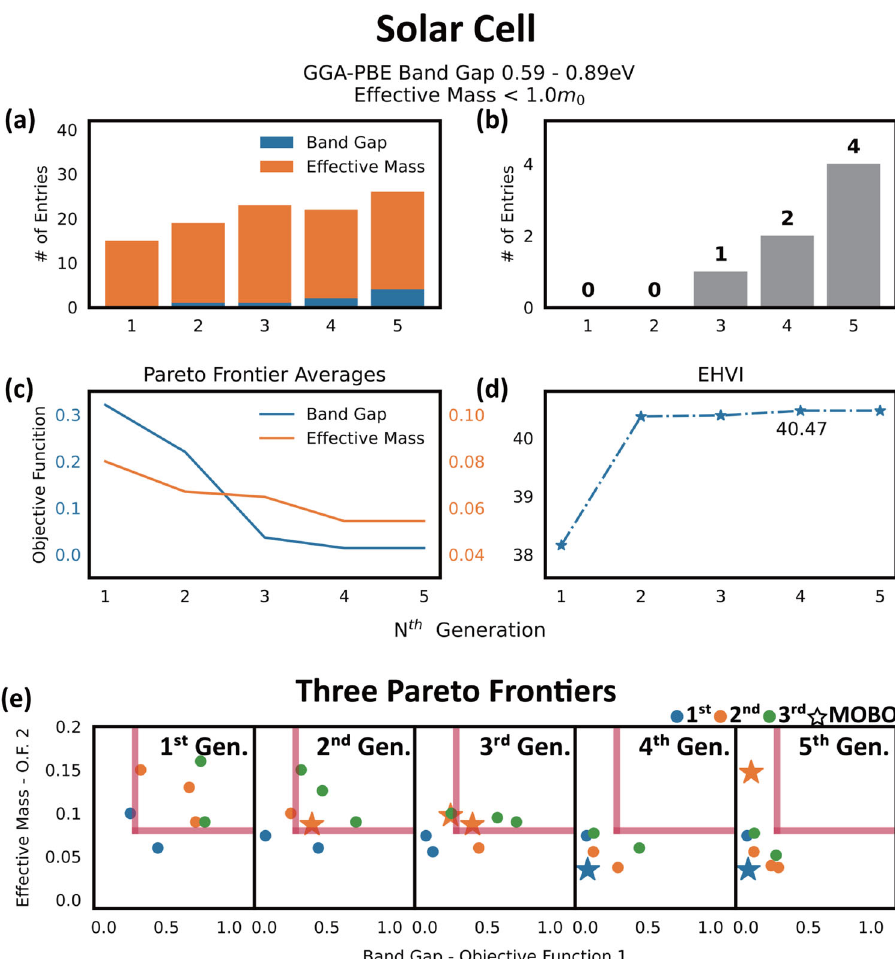
Fig. 4 NSGA-II/MOBO screening results targeting HOIPs for solar cell applications. a The numbers of HOIP candidates exhibiting 0.61 < GGA_Eg < 0.87 eV and m e/h < m o . b The number of promising entries simultaneously ful fi lling the above conditions. c The band gap and effective mass objective functions averaged from the fi rst Pareto frontier are plotted as a function of the NSGA-II/MOBO round. Note that the band gap objective function does not represent the pristine band gap itself, and the effective mass objective function is the maximum effective mass out of electron and hole masses. d The EHVI is plotted as a function of the MOBO round. e Pareto-sorted entries were collected from the top three Pareto frontiers of each generation for the NSGA-II/MOBO iteration (the MOBO nominated entries are separately marked as